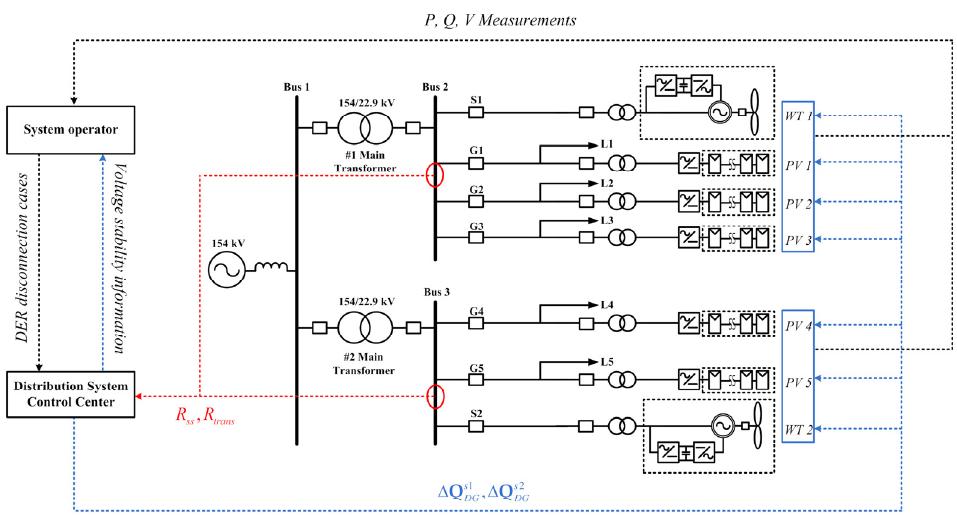
Figure 2. Practical “Y” distribution system in South Korea with the PV and wind generators.